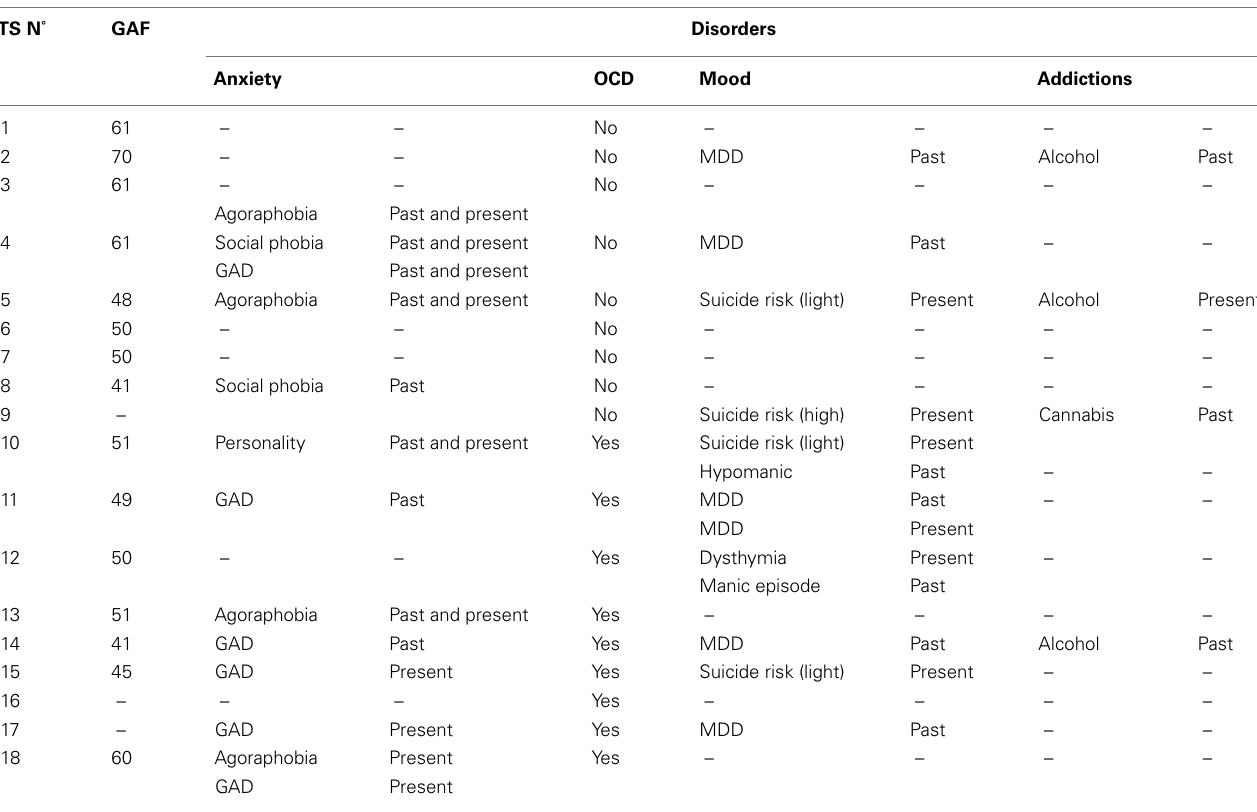
Table 2 | Details ofTourette’s syndrome (TS)